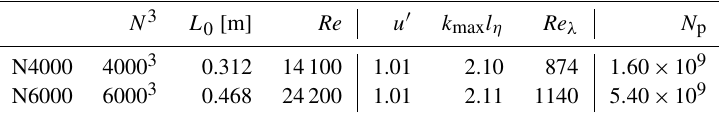
Table 3. Case configurations and typical turbulence statistics. Re = U 0 L 0 /ν , u (cid:48) is the rms of flow velocity fluctuation, k max ( = N/ 2 ) is the maximum wavenumber, l η is the Kolmogorov scale, and Re λ is the Taylor-microscale-based Reynolds number. N p is the total number of particles. N 3 L 0 [m] Re u (cid:48) k max l η